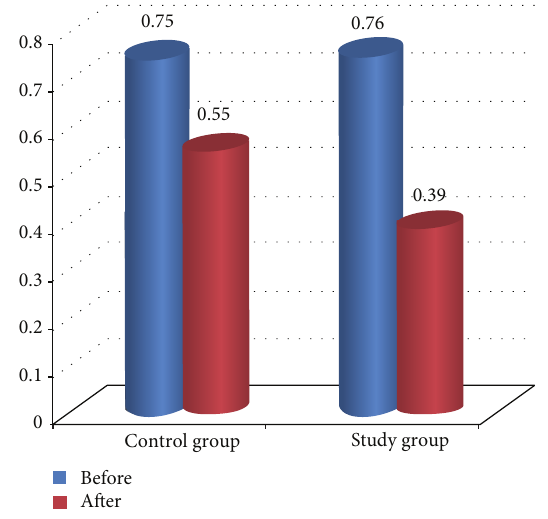
Figure 2: Comparison between pre- and posttreatment in H \ M ratio for both groups.